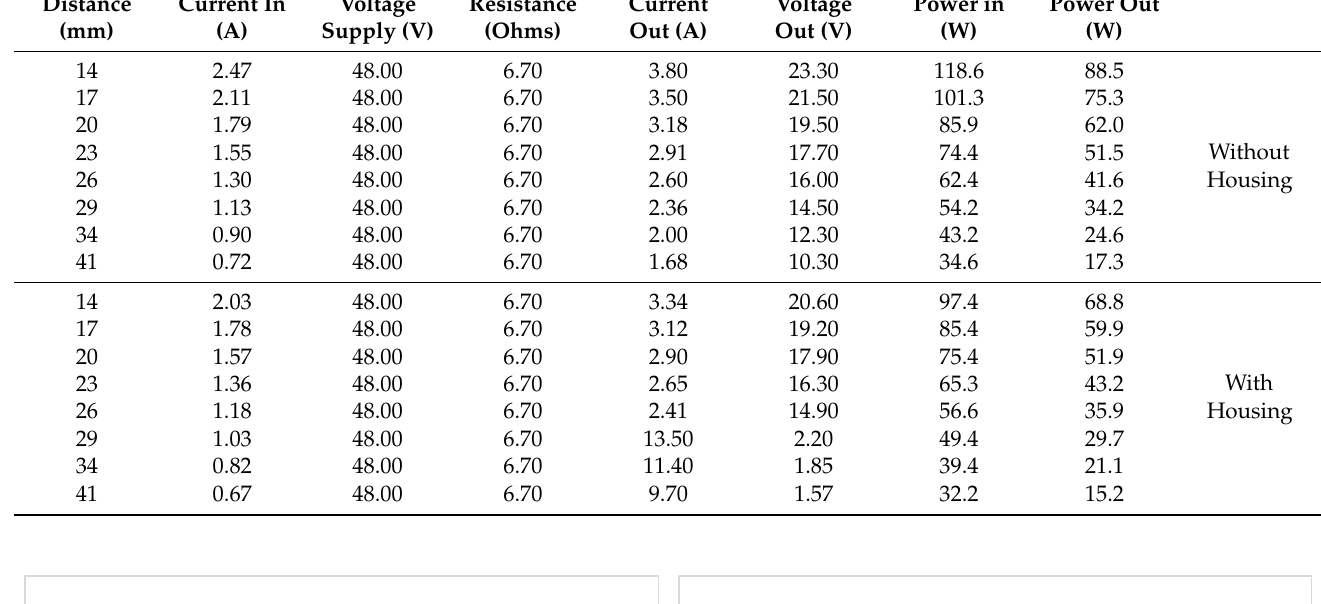
Table 13. Power over distance: electric parameters and power efficiency of the 48 V module.